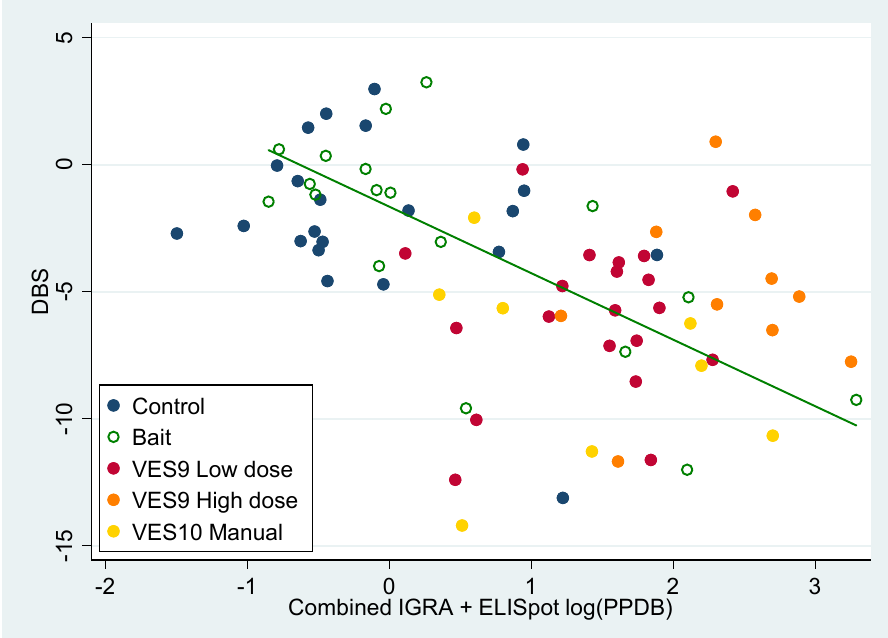
Figure 6. Disease Burden Score (DBS) of badgers post mortem plotted against purified-protein derivative (PPD)B reaction post-vaccination (PPDBm), from a combination of log-transformed immune absorbent spot (ELISpot) assay and IGRA measures. Observations are classified into five treatment groups as in the legend. The line is fitted to the observations from the bait vaccination treatment only ( P = 0.0003); although the trend roughly matches the di ff erences between treatments, there was no significant trend related to PPDBm within the other treatments (Table 11). Table 11. Analysis of variance of Disease Burden Score (DBS) using combined PPDBm as the only measure of post-vaccination immunology.